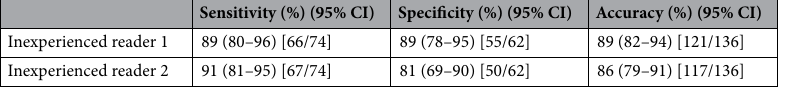
Table 2. Diagnostic performance of residual or recurrent tumour. 95% CI 95% confidence interval.